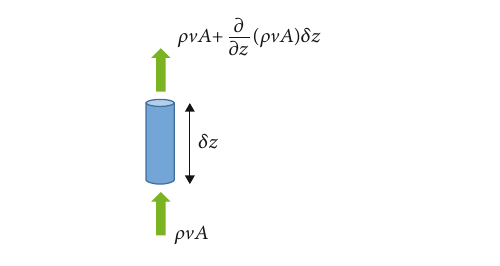
Figure 5: Schematic of in fi nitesimal